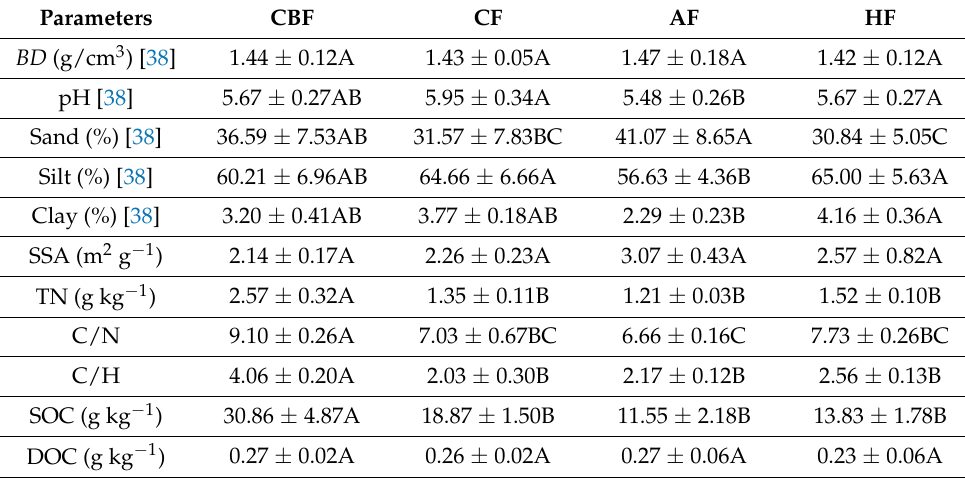
Table 2. Soil physicochemical properties of different forest